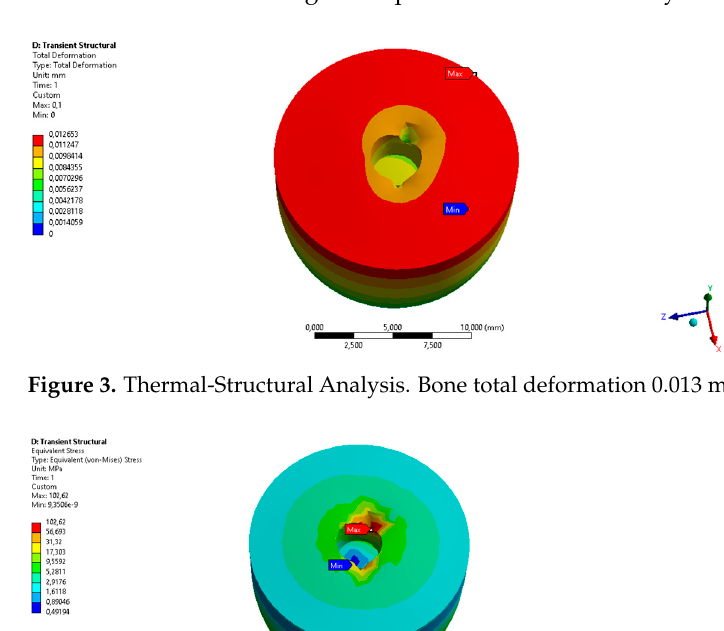
Figure 4. Thermal-Structural Analysis. Equivalent Stress 102.6 MPa.